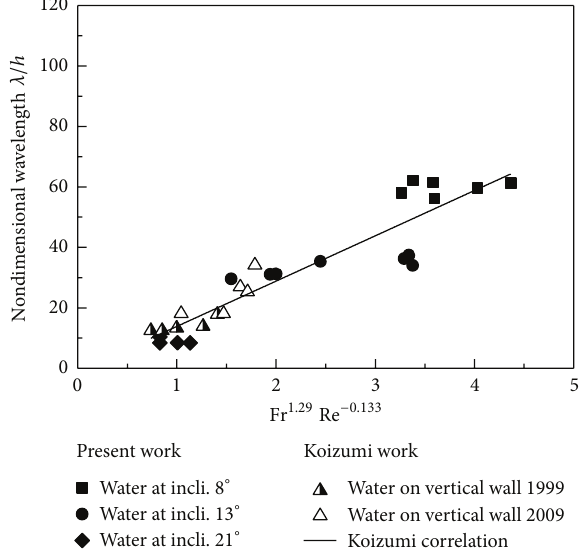
Figure 8: Comparison of nondimensional primary pulse spacing between experiments and Koizumi